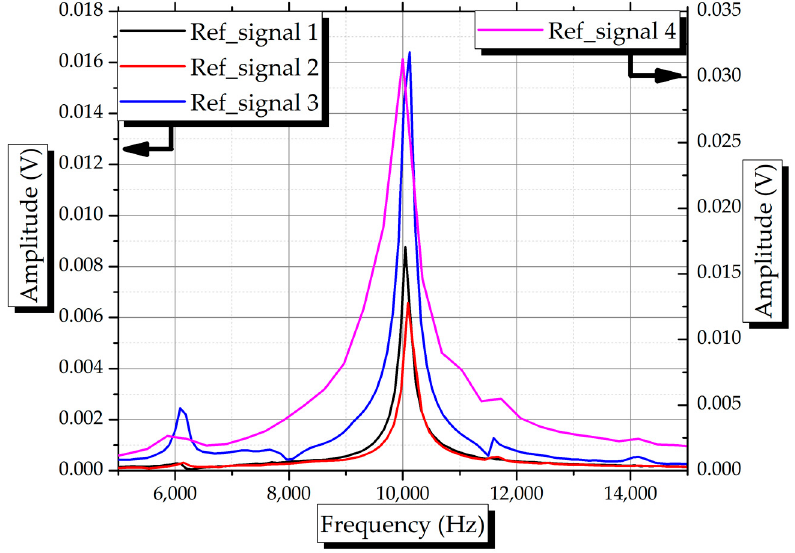
Figure 8. Multiple measurements for the fundamental frequency of vibration.